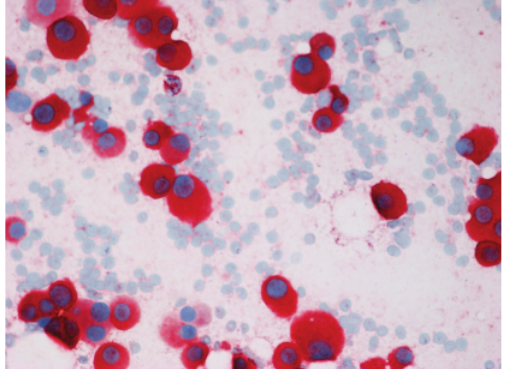
Figure 3: Mononuclear cells positive for Melan-A, consistent with metastatic